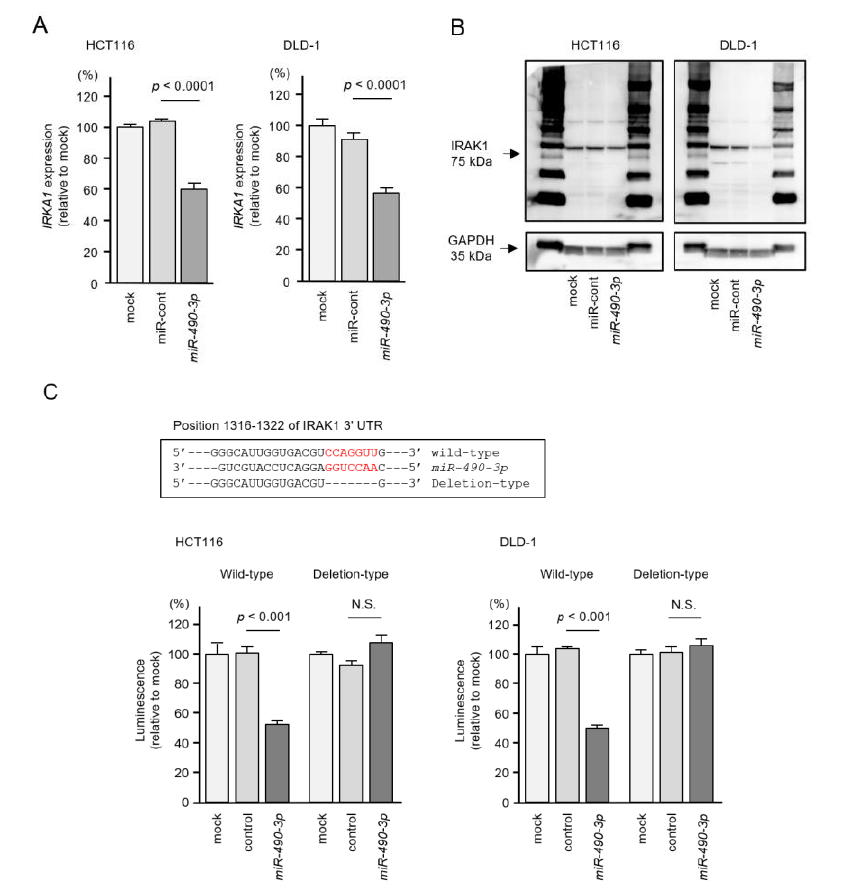
Figure 7. Direct regulation of IRAK1 expression by miR-490-3p in colorectal cancer (CRC) cells (HCT116 and DLD-1). ( A ) Real-time PCR showing significantly reduced expression of IRAK1 mRNA at 72 h after miR-490-3p transfection in CRC cells. Expression of GAPDH was used as an internal control. ( B ) Western blot showing reduced expression of IRAK1 pro- tein at 72 h after miR-490-3p transfection in CRC cells. Expression of GAPDH was used as an internal control. ( C ) One putative miR-490-3p binding site predicted within the 3′-UTR of IRAK1 by TargetScanHuman analyses (upper panel). Dual luciferase reporter assays showed reduced luminescence activity after cotransfection of the wild-type IRAK1 3′-UTR se- quence (containing the miR-490-3p binding site) with miR-490-3p in CRC cells (lower panel). Normalized data were calcu- lated as the Renilla/firefly luciferase activity ratio (N.S., not significant).